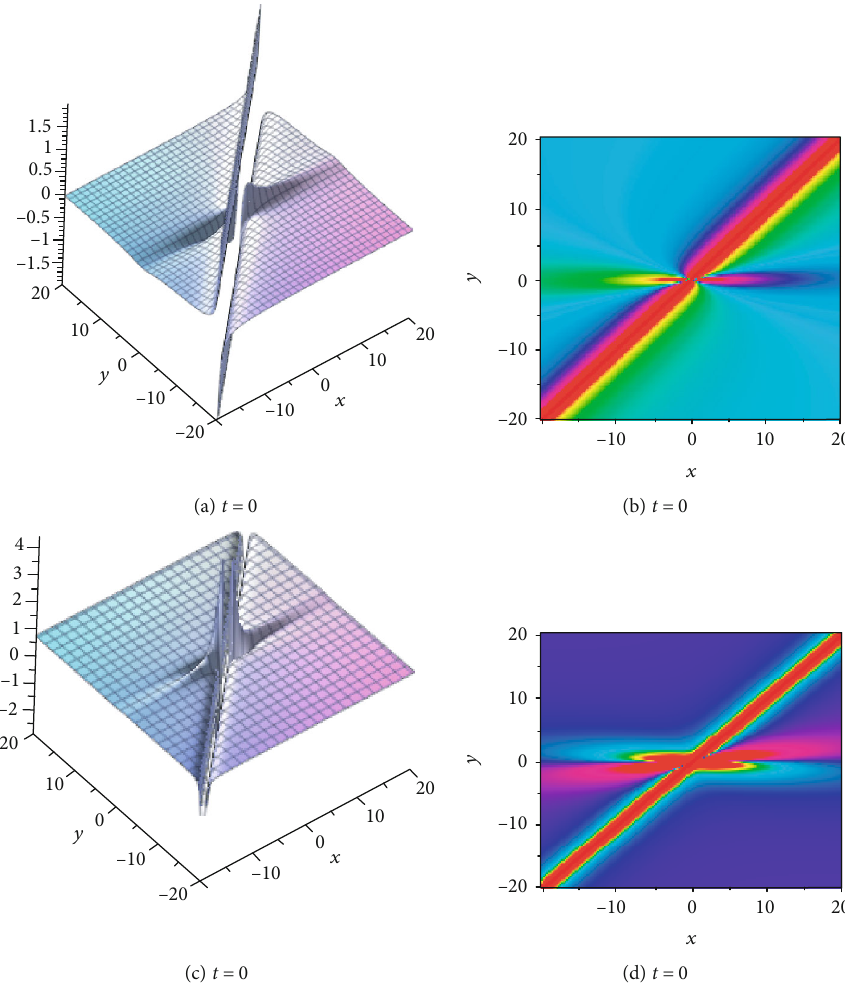
= 1 , a = 1 : 5 , a = 0 , a = 2 , a = 4 , a = 0 , and 1 3 4 5 6 8